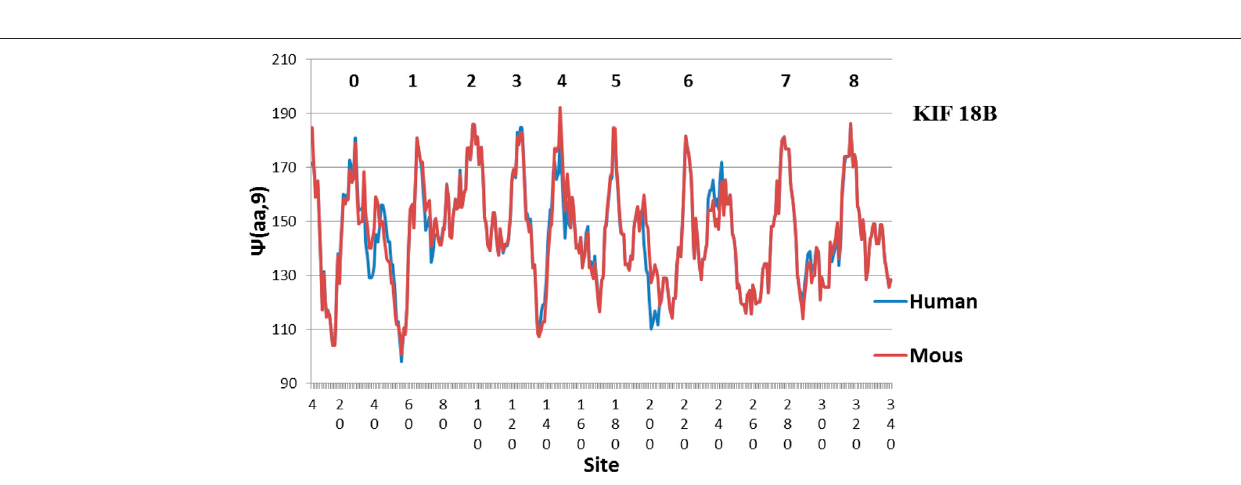
FIGURE 3 | Compared to Figures 1 , 2 , Mouse KIF18B is now similar to Human KIF18B. The main difference is Peak 4, which is more level in Human (MZ